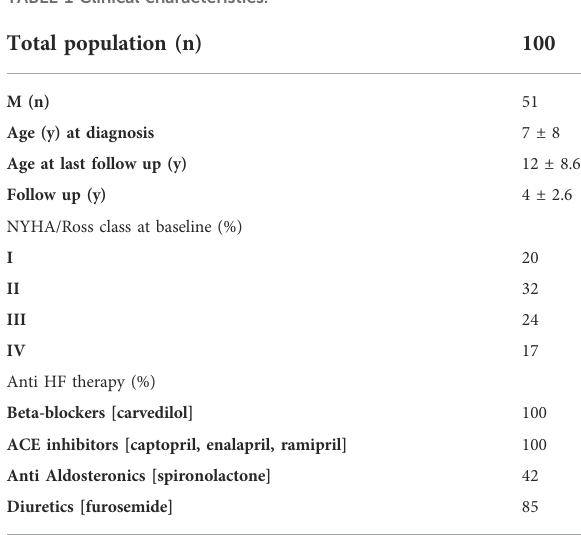
TABLE 1 Clinical characteristics.